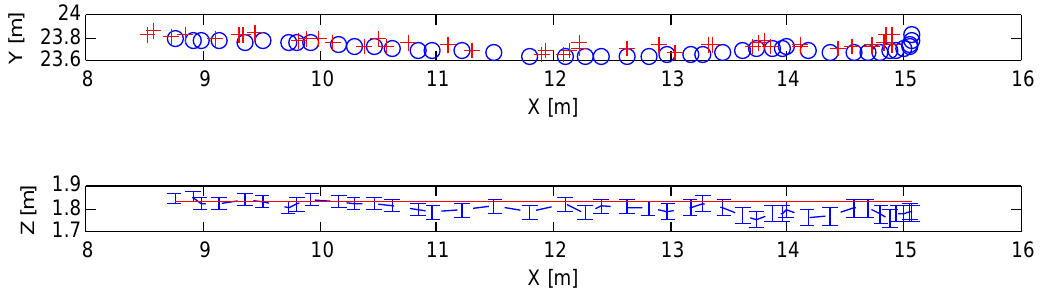
Figure 6: Results for a person approaching the cameras. Reference data is shown in red, our results in